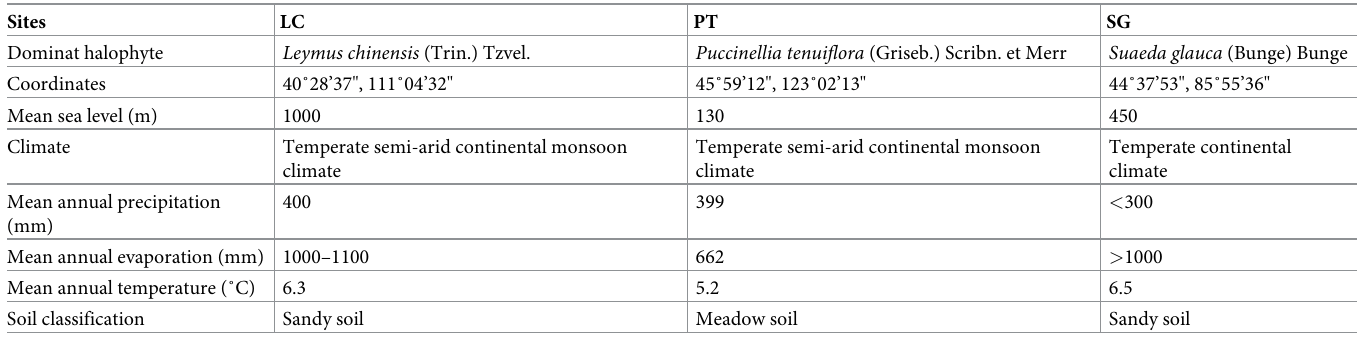
Table 1. General description of geography at the three experimental